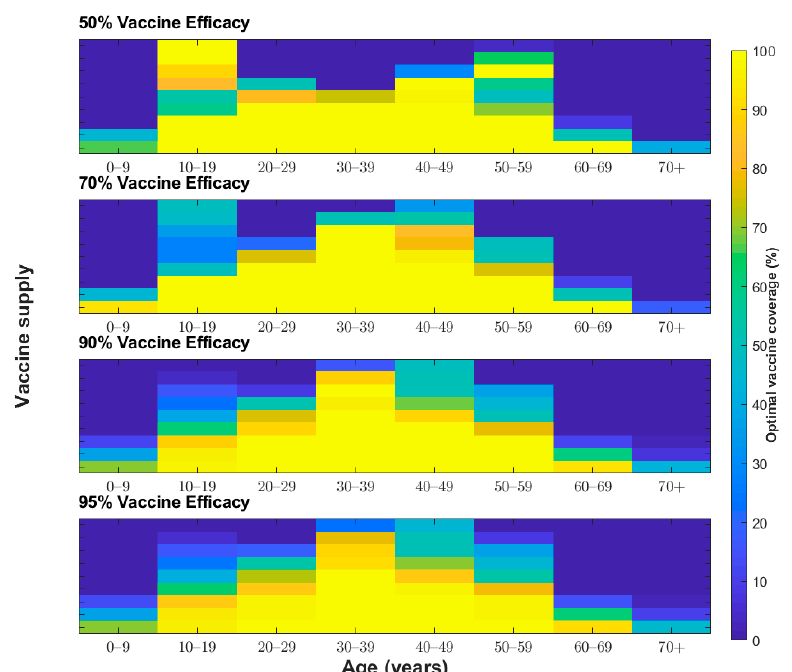
Figure 5. Proportion of individuals vaccinated from each age group ( x -axis) to minimize the total number of deaths associated with COVID-19 under various vaccine coverage levels ( y -axis) and vaccine efficacies (50%, 70%, 90%, and 95%).